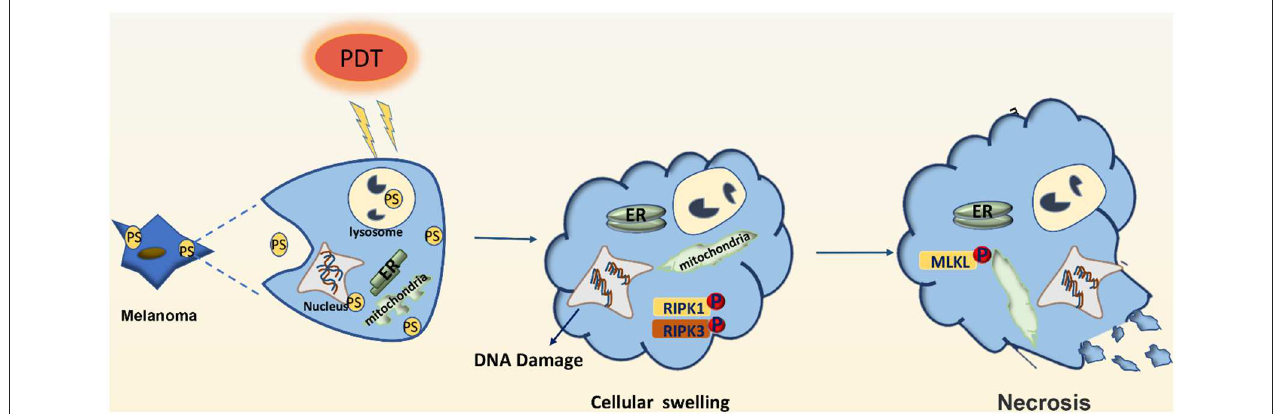
FIGURE 2 | Effector mechanisms leading to necrosis after photodynamic therapy of melanoma. PDT may induce DNA damage and swelling of organelles, leading to necrosis of melanoma cells. PDT may also activate the RIPK1 pathway to promote the phosphorylation of downstream RIPK3, make the phosphorylation of RIPK3